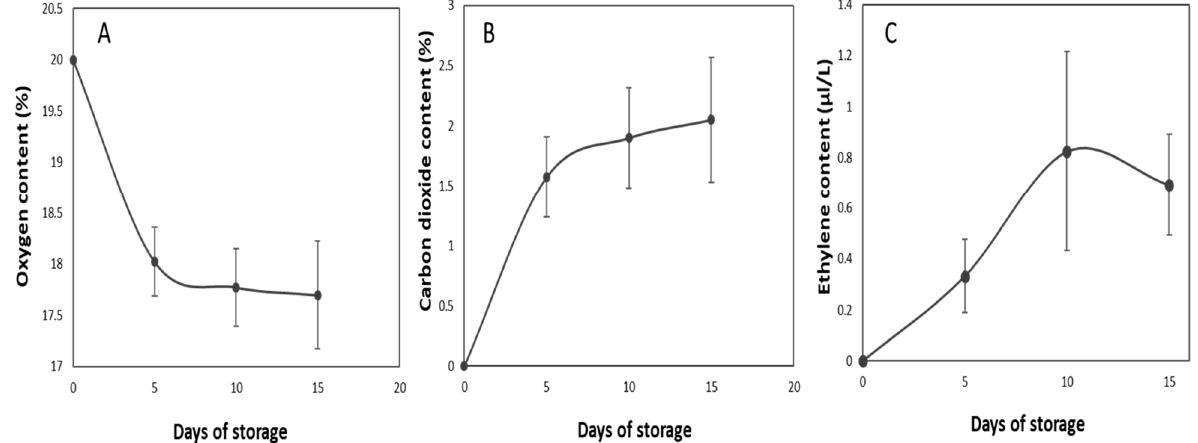
Figure 5. Malondialdehyde (MDA) content ( A ) and electrolyte leakage ( B ) of sweet peppers pre ‐ treated with 10% CO 2 for 12, 24, and 48 h, as well as untreated and modified atmosphere packaging (MAP) with 50,000 cc ∙ m − 2 ∙ day − 1 ∙ atm − 1 OTR film after treatments and the last day of storage. The ver ‐ tical bars represent ± SE of n = 4, and different letters indicate a significant difference at p ˂ 0.05.